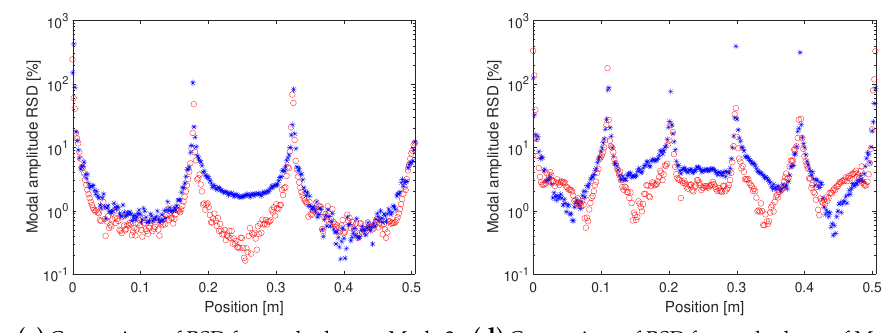
Figure 11. Comparison of relative standard deviation before (blue asterisks) and after (red circles) the renormalization of mode shapes obtained for ten